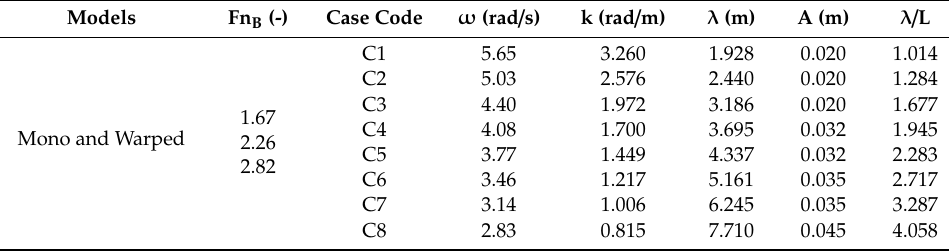
Table 4. Validation Study of Transfer Functions for the Selected